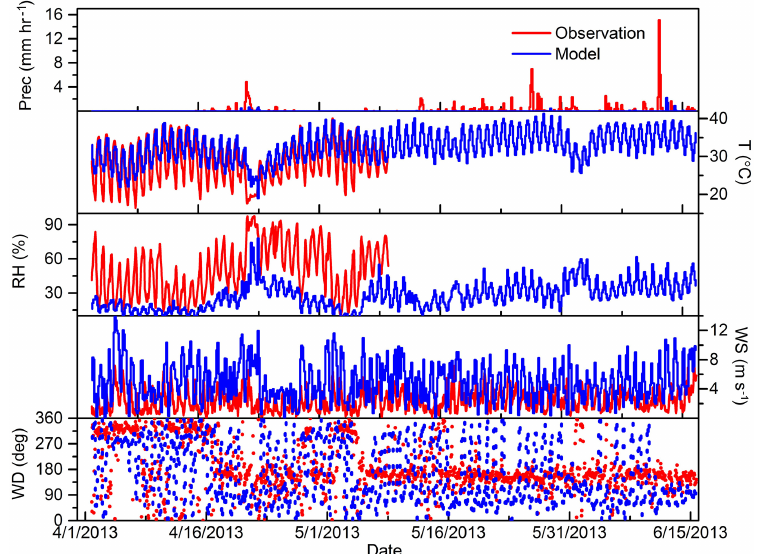
Figure 2. Time series of hourly average observed (red) and model estimated (blue) meteorological parameters at Lumbini, Nepal, for the entire sampling period from 1 April to 15 June